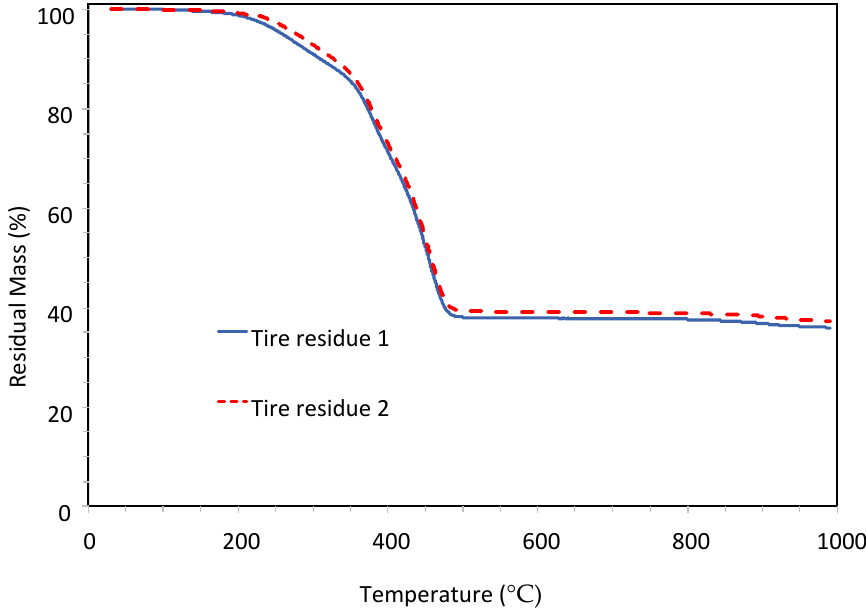
Figure 2. TGA of tire residue pyrolyzed under nitrogen. Two runs were performed under identical conditions. The heating rate was 10 °C min −1 .